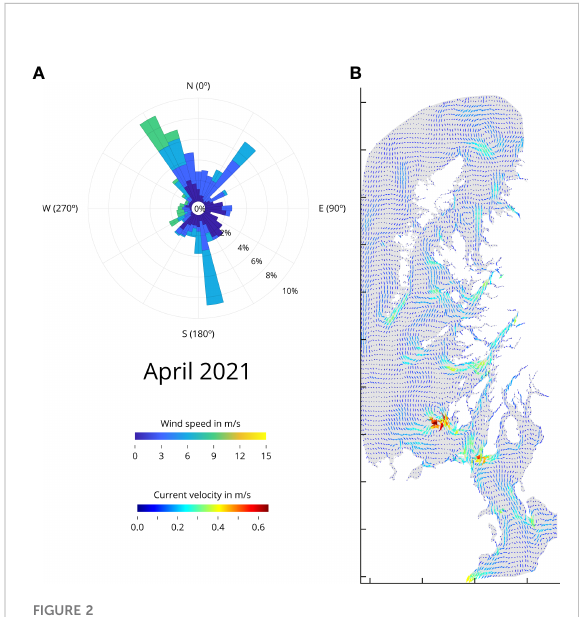
FIGURE 2 Wind rose and surface current velocity for April 2021. (A) Wind rose. The wind direction determined by where it blows to. The color scale represents wind speed (m/s), whereas the inner circle represents frequency. The data are from WRF v4. (B) Average current velocity between 0 m to 10 m below sea level (m/s). Detailed Wind roses and for average surface current velocity for March, April, and May 2021 and 2020 are available Supplementary Figures S1, S2